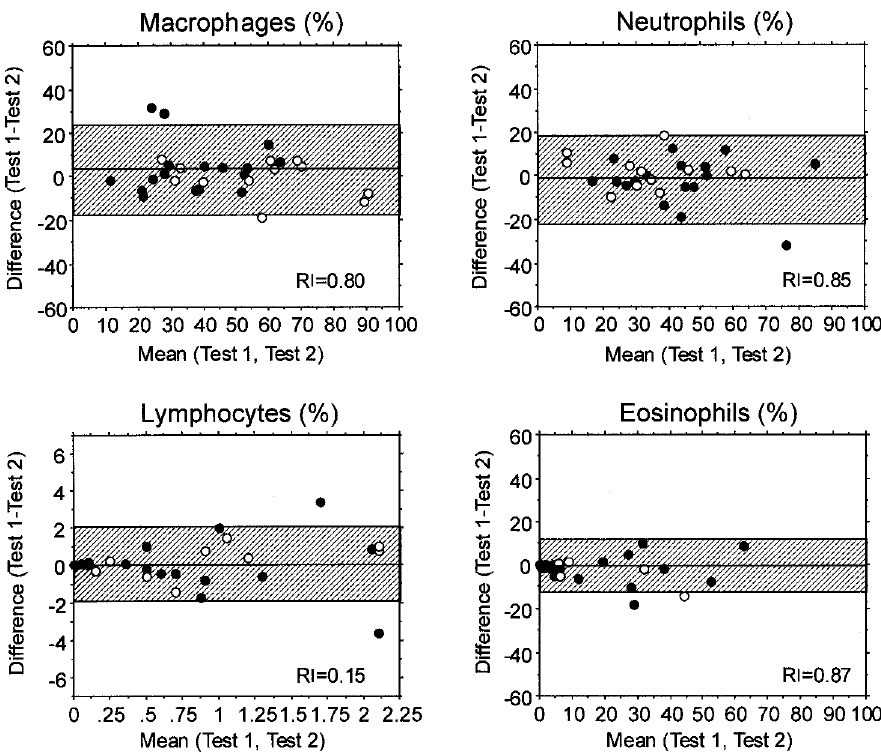
FIG. 1. Plots of differences between sputum induction procedures (test 1 – test 2) versus mean values for sputum cell percentages. Open circles, untreated patients; closed circles, treated patients. The hatched area includes the mean of differences between test 1 and test 2 ± two standard deviations of the